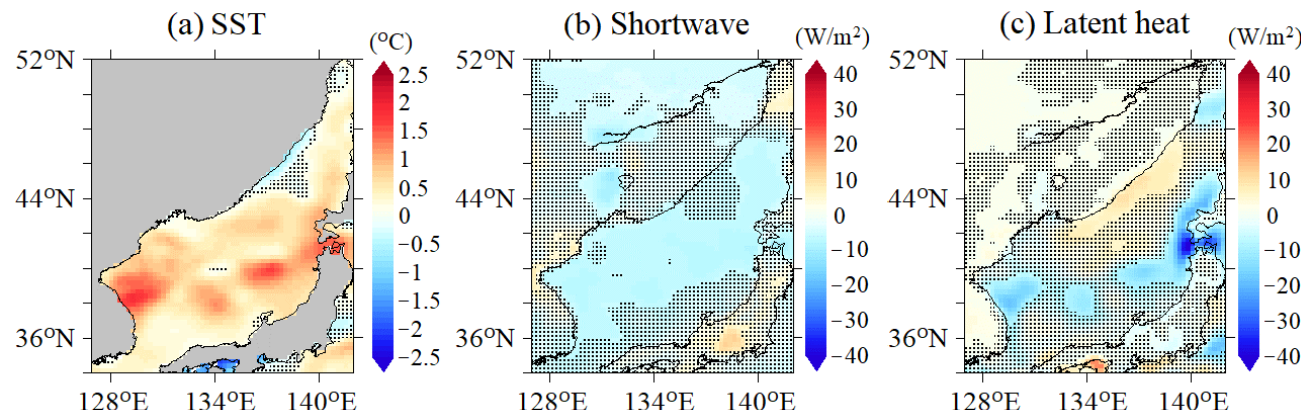
Figure 8. Composite difference during the top third (strong) and the bottom third (weak) MHW characteristics (duration, coverage, mean intensity) in EJS in winter (strong–weak). ( a ) Sea surface temperature, ( b ) shortwave radiation, and ( c ) latent heat flux (downward positive). The dotted areas indicate insignificant values at a 95% confidence level using Student t -test ( p -value > 0.05).